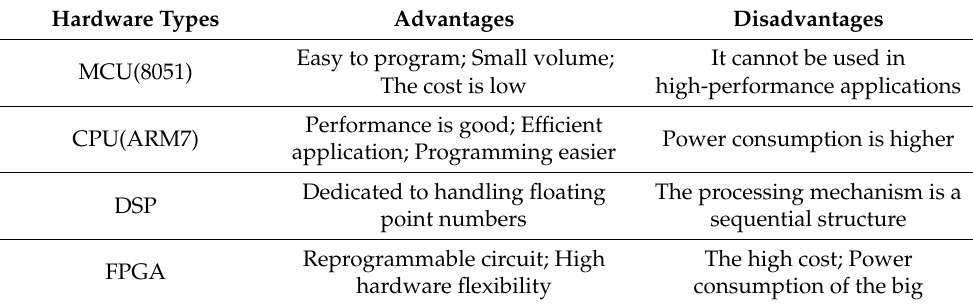
Table 3. Common embedded hardware supported by LabVIEW.